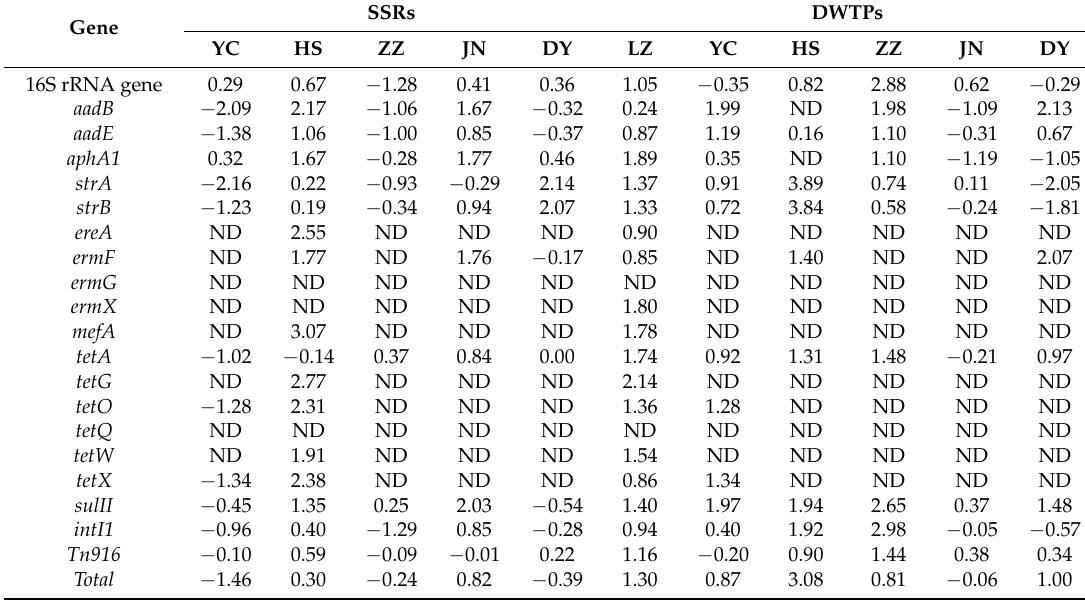
Table 1. The log removal of ARGs in the treatment processes of six sample